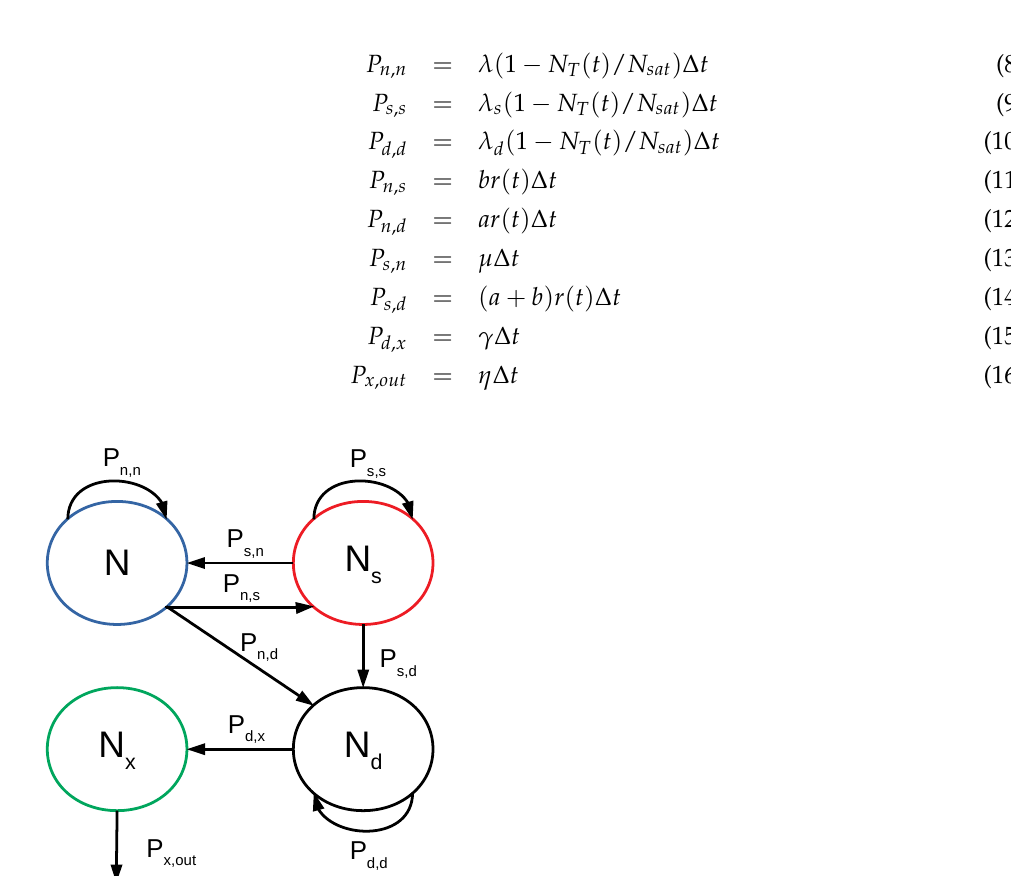
Figure 1. Sketch of our stochastic model with transfer probabilities between compartments and flux arrows. P i , j is the probability of a cell in compartment i to go to compartment j (i.e., N i → N i − 1, N j → N j + 1). P i , i is the probability of duplication of a cell in compartment i (i.e., N i → N i + 1). ( n , d , s , x ) refer to compartments of non-damaged, doomed, sub-lethally damaged, and dead cells, and “out” is used for cells leaving the